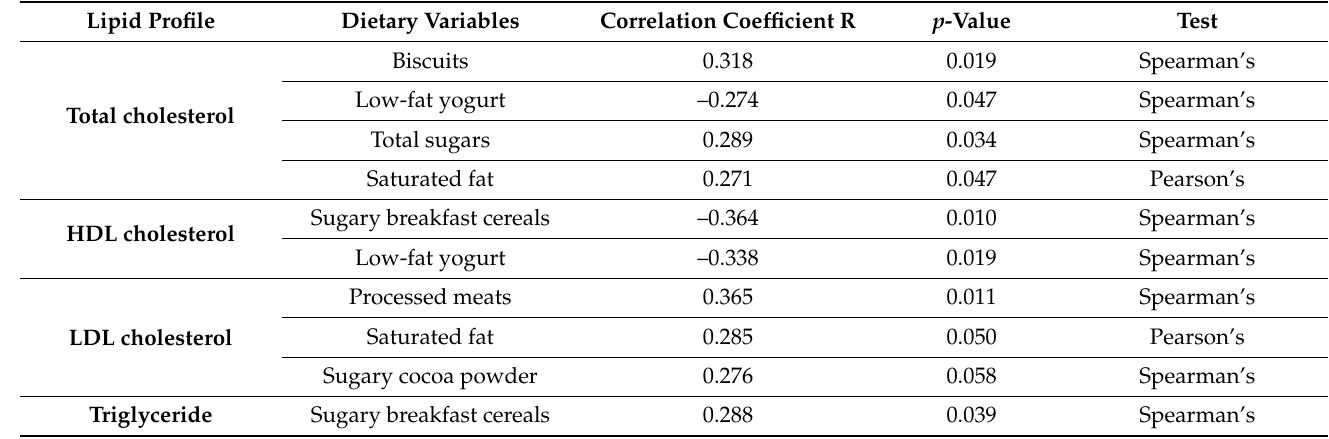
Figure 8. Type of stool data of 72 CD pediatric individuals referred from the baseline (inclusion) and after six (follow-up) 188 and twelve months after the intervention (final). 189 Table 1. Correlations between lipid profile and dietary intake of 72 celiac